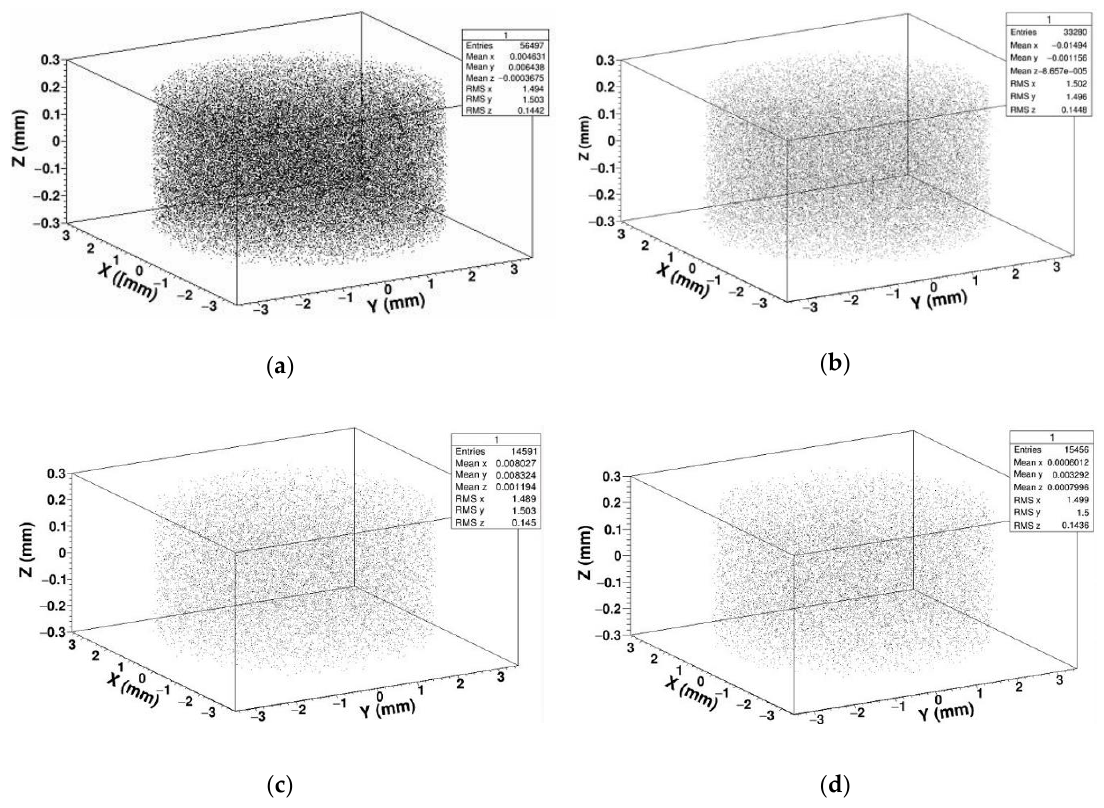
Figure 4. Primary knock-on atom (PKA) spatial distribution in SDD generated by neutrons: ( a ) PKA spatial distribution for 1 MeV neutrons; ( b ) PKA spatial distribution for 2 MeV neutrons; ( c ) PKA spatial distribution for 14 MeV neutrons; ( d ) PKA spatial distribution for 20 MeV neutrons.